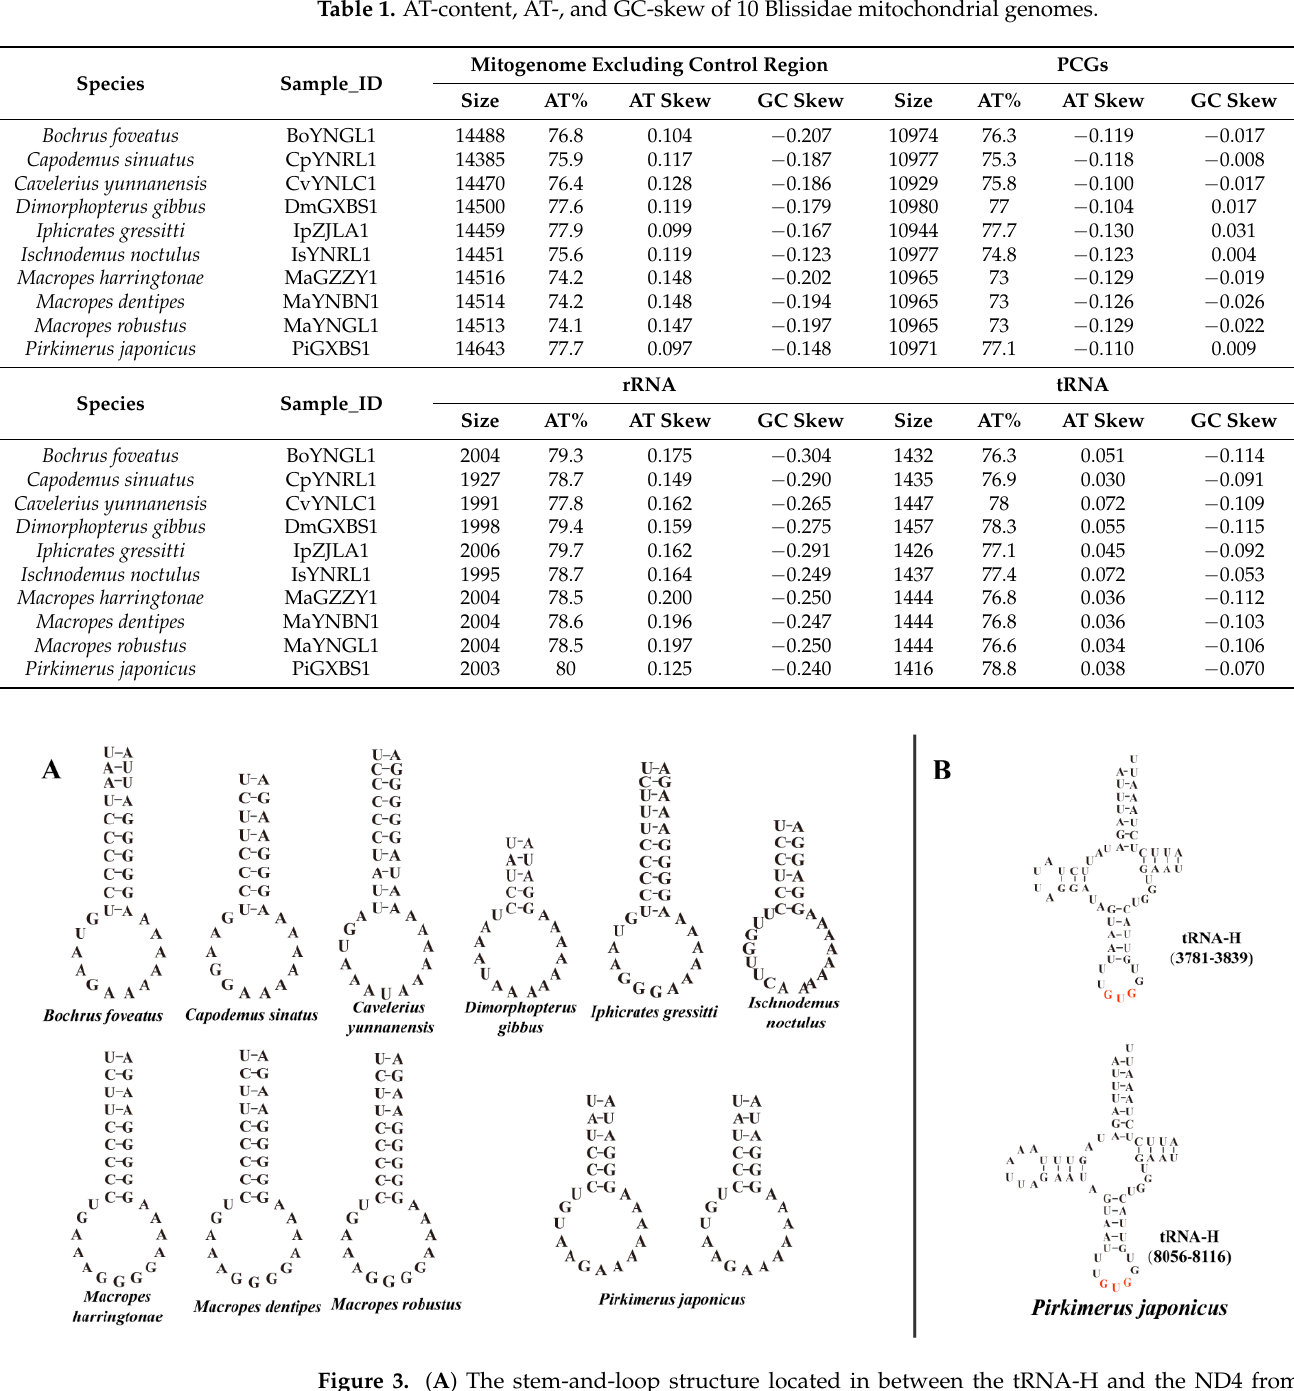
Figure 3. ( A ) The stem-and-loop structure located in between the tRNA-H and the ND4 from Blissidae. ( B ) Secondary structures of two tRNA-H of Pirkimeru japonicus . Numbers in parentheses indicate the location in the mitogenome.